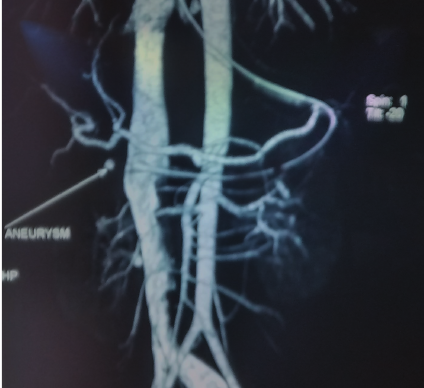
Figure 1: CT abdominal angiography showing the aneurysm of gastroduodenal artery.